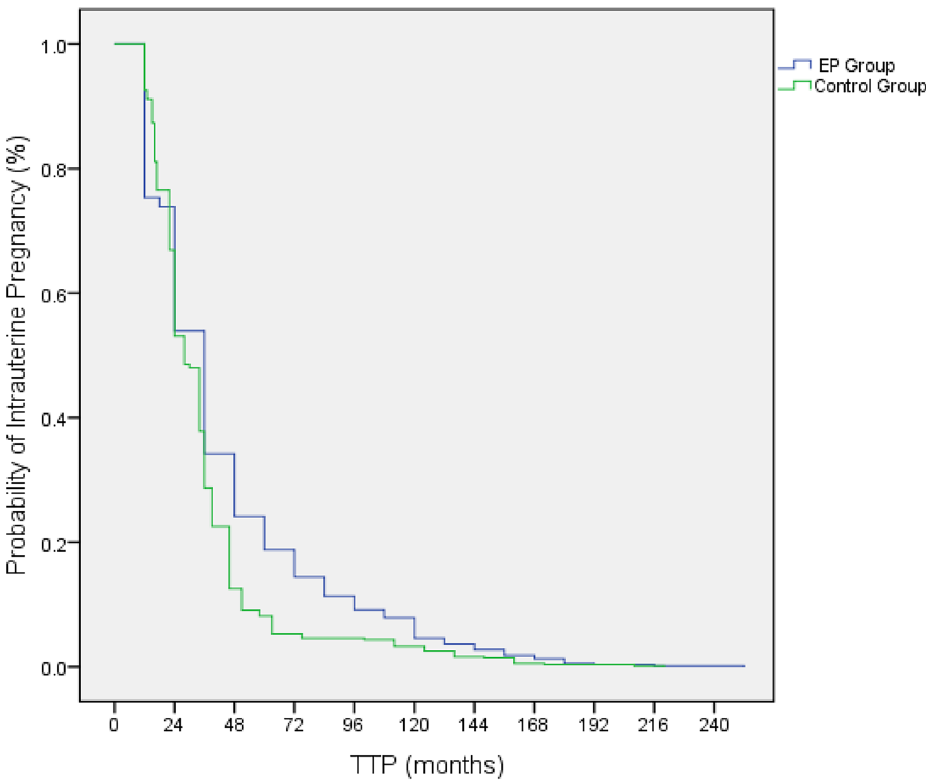
Figure 1. Kaplan–Meier curves for time to pregnancy in women with EP and the control. Log-rank (Mantel– Cox) comparison: P <